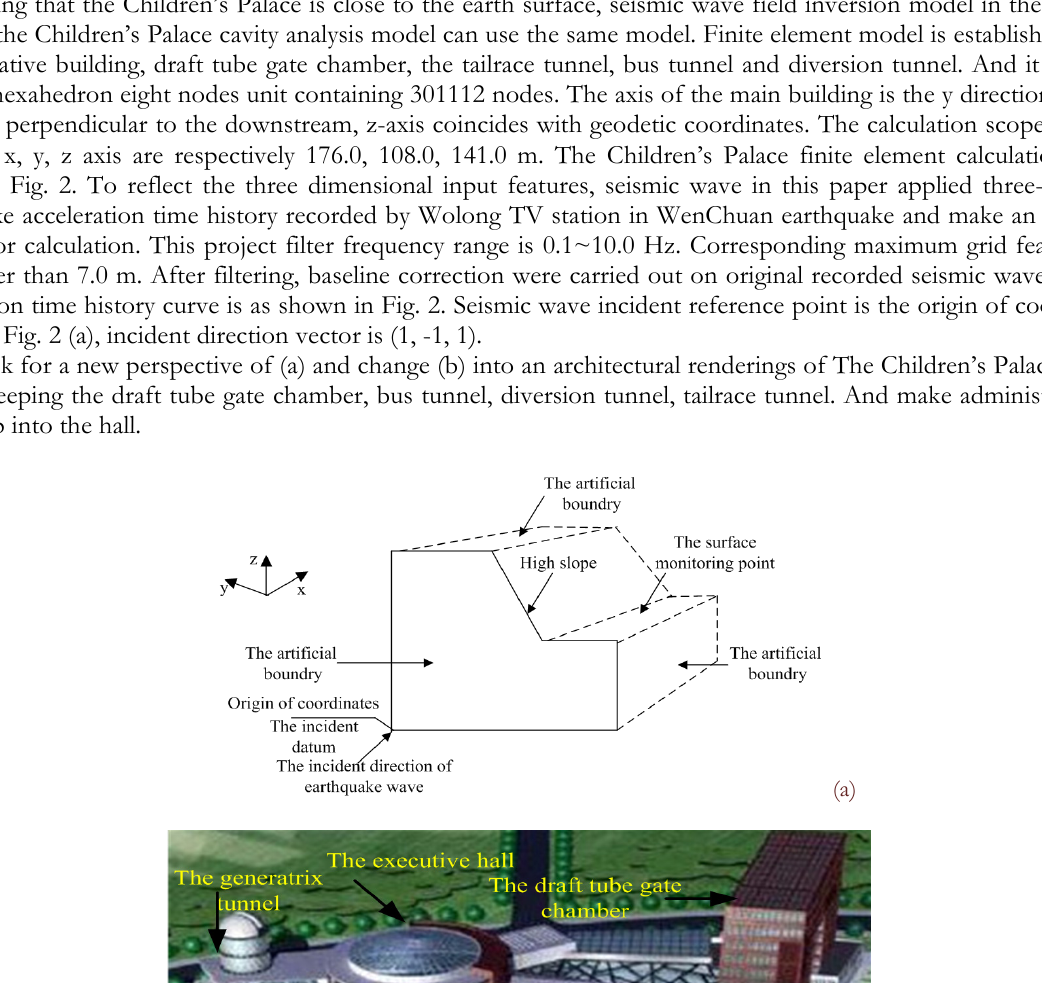
Cavity Earthquake Disaster